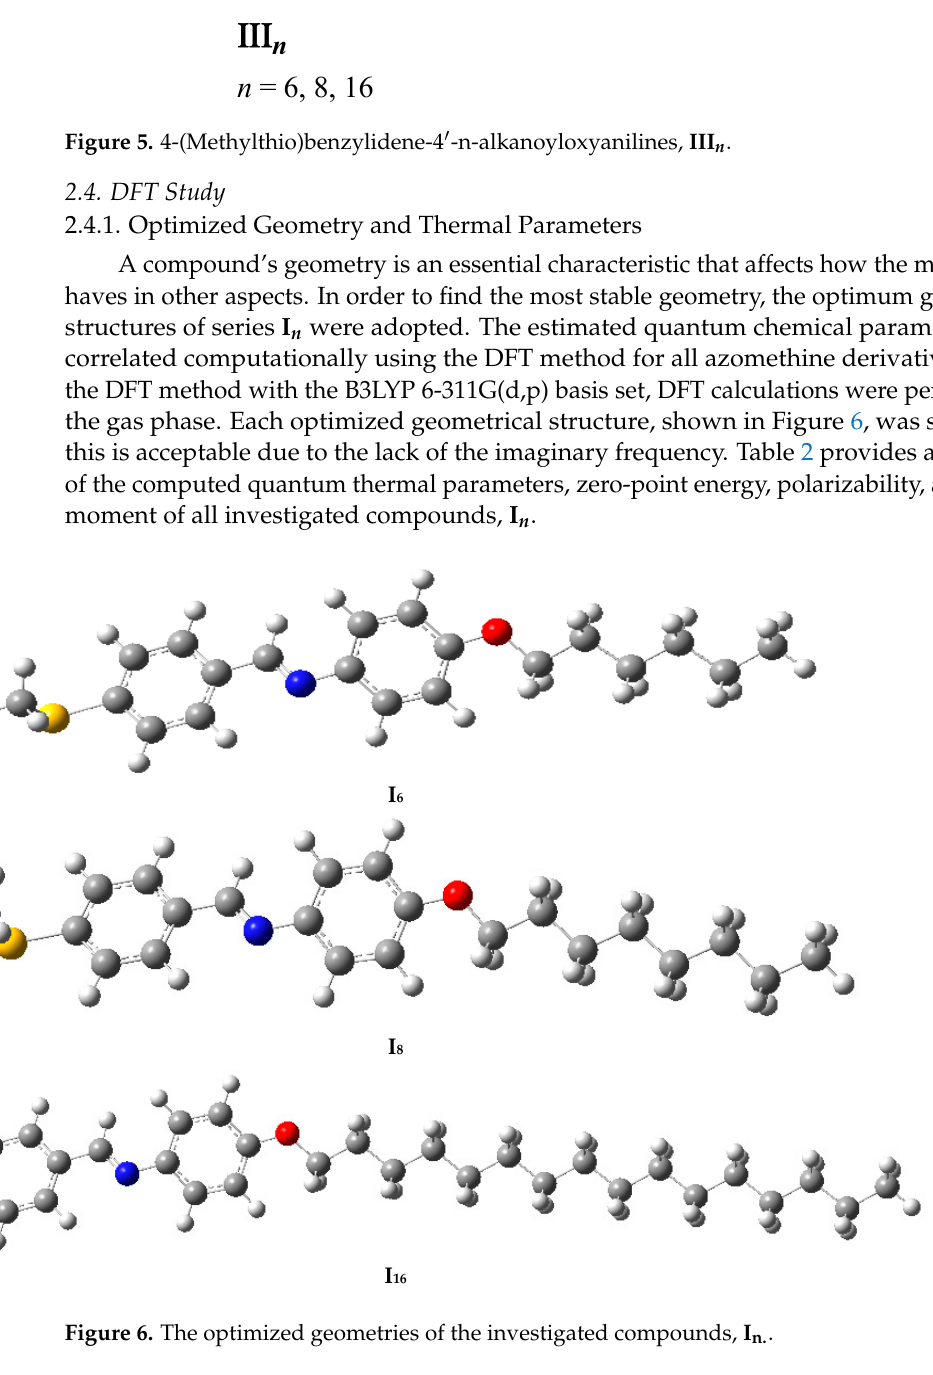
F Figure 4. N -4-fluorobenzylidene-4-(alkyloxy)benzenamine, II n . Compounds II n differ from our group I n only in the terminal aromatic ring of their mole- cules; the latter have F substituent at the terminal benzene nucleus while the former have a methylthio group there. It was reported that compounds II n are fully smectogenic, possessing purely smectic A phases, while I n are purely nematogenic, except the I 16 derivative. A compar- ison between our current group I n and II n is made in order to examine the impact of the ter- minal methylthio group insertion into the terminal ring of the molecule on the formation, na-